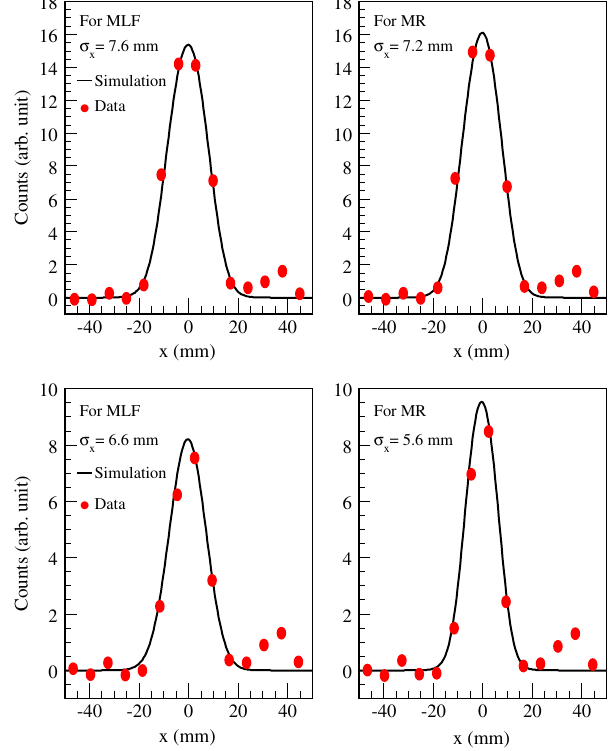
FIG. 12. Comparison of the extracted beam profiles for the MLF and MR painting. The upper plots are for a beam power of 350 kW, where the lower ones are those for 150 kW. The measured beam profile by the MWPM are depicted by red solid circles, where lines are the corresponding numerical simulation. The profile width with an initial smaller injection painting area for the MR (right) is confirmed to be narrower as compared to that of a larger painting area for the MLF (left). The difference is more significant for a relatively lower beam inten- sity as can be seen in the lower plots. The corresponding simulation results are found to be quite consistent to those with measurements.